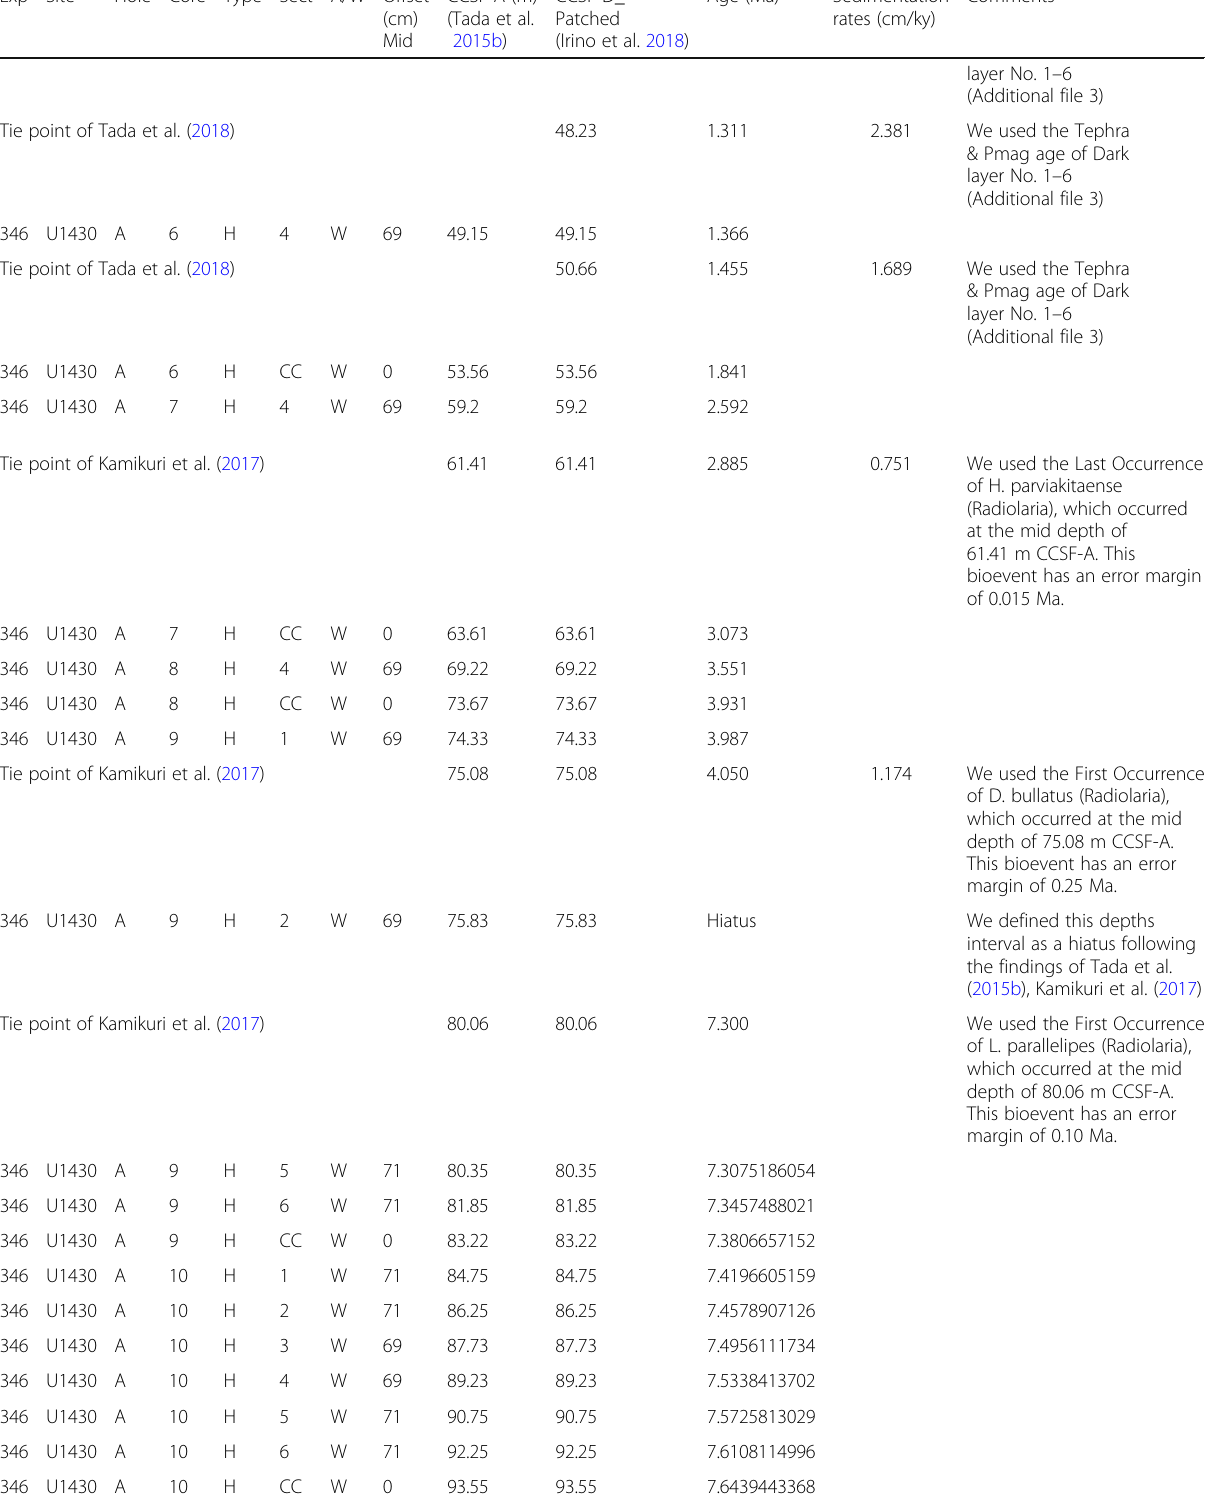
Table 2 Samples used, biostratigraphic tie points, and related sedimentation rates at IODP Site U1430 (cm/ky) (Continued) Exp